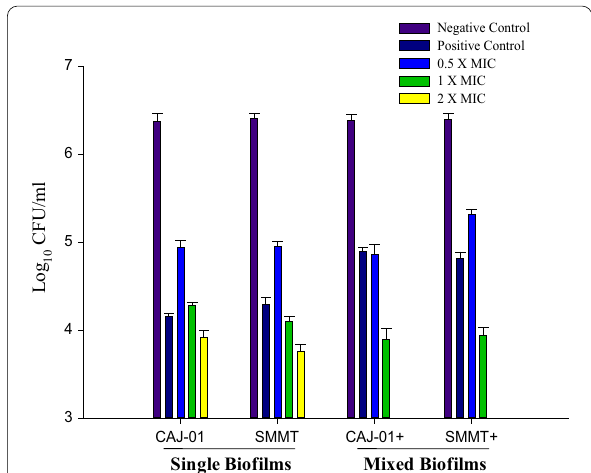
Fig. 1 Viability of pre-formed CAJ-01 and S. mutans MTCC497 single and mixed biofilm cells on exposure with different concentration of the eugenol. Negative Control: Untreated single and mixed biofilm cells. Positive Control: CHX (200 µg/mL) treated cells, CAJ-01 cells of CAJ-01 in mixed biofilms, SMMT